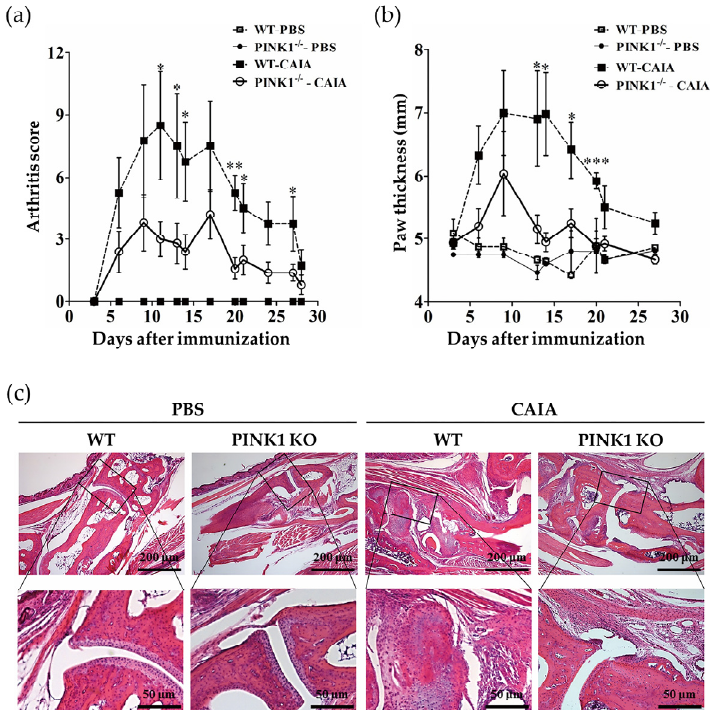
Figure 4. Pink1 deficiency alleviates collagen antibody-induced arthritis in mice. Three days, 14 days, and 21 days after injection with collagen antibody cocktail, mice received intraperitoneal (i.p) injections of 50 μ g lipopolysaccharide. Arthritis incidence and severity were assessed by clinical scoring ( a ) and by measuring paw thickness ( b ) from Days 3 – 28. Disease severity was graded on a scale of 0 – 4 as described in the materials and methods. Footpad thickness was measured three times per week. ( c ) Paws were removed from each group of mice after euthanasia, fixed for seven days in 4% paraformaldehyde, decalcified for 21 days in decalcification solution, dehydrated, and embedded in paraffin blocks. Serial sections (10 μ m) were cut and stained with hematoxylin and eosin (H&E). Data are expressed as means ± SEM ( n = 4 mice/group). * p < 0.05; ** p < 0.01; *** p < 0.001.